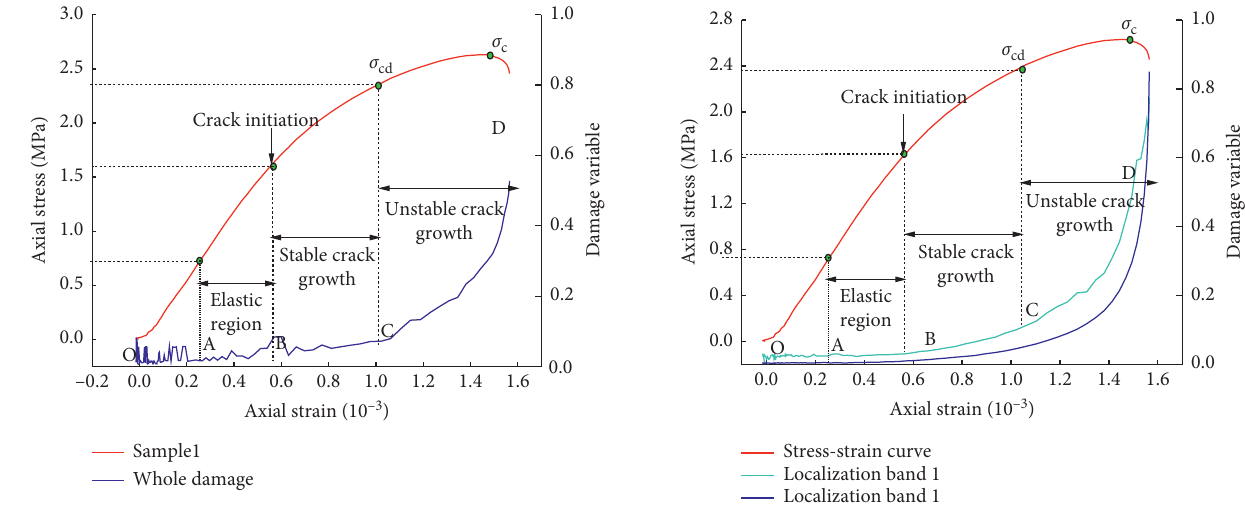
Figure 7: The relationship between damage variable and loading curve of SLB1.